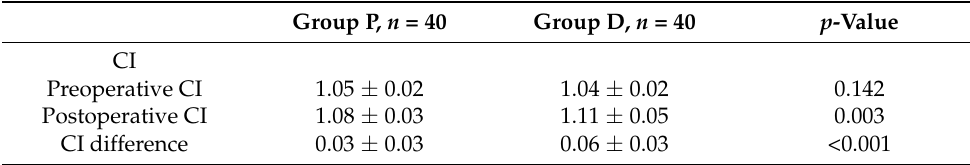
Table 4. The change in left bronchial tortuosity between two